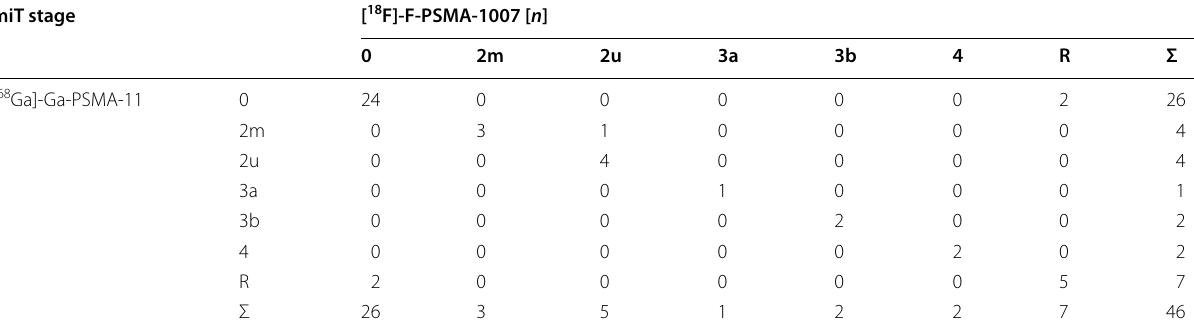
Table 4 miT stage by tracer miT